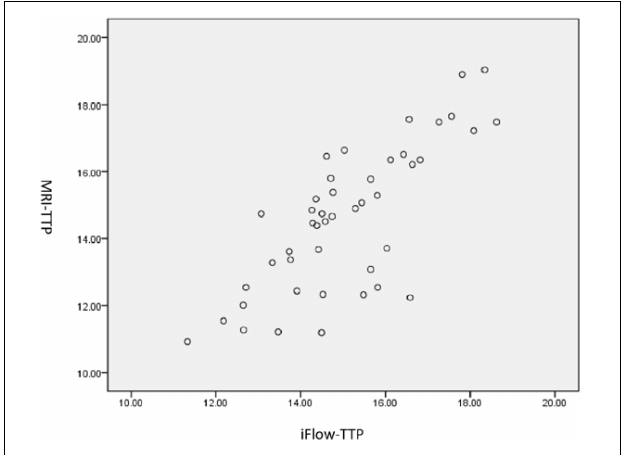
FIGURE 2 | Pearson correlation in TTP between MRIPWI and iFlow outcome in patients with